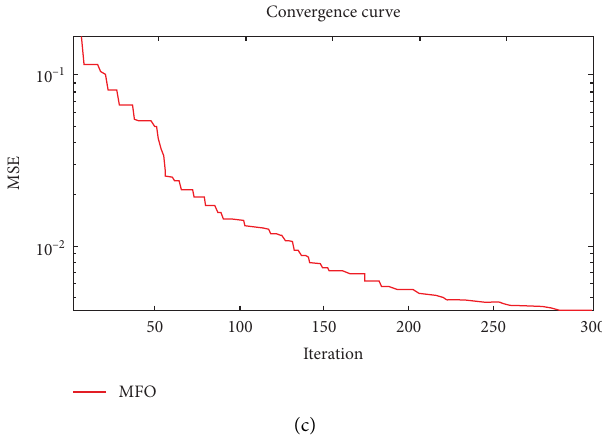
Figure 15: MSE calculated by MFO for predicting. (a) Crack width (CW), (b) volumetric shrinkage (VS), and (c) linear shrinkage (LS).